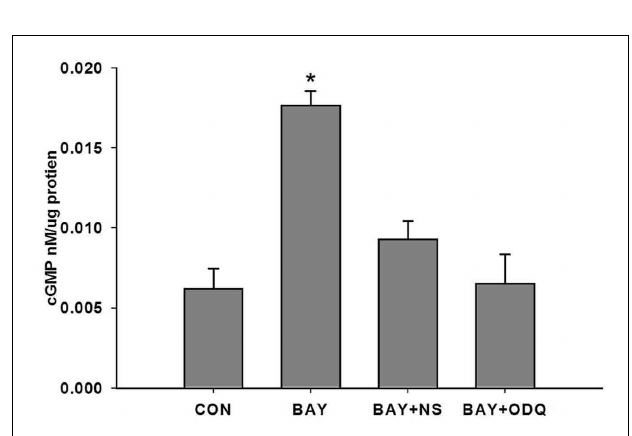
FIGURE 3 | (A) Effect of zaprinast (ZAP) on BAY 41-2272 (BAY)-induced increases in cGMP.VSMCs were pretreated with ZAP (ZAP, 10 μ M) or vehicle for 30min prior to stimulation with BAY (10 μ M) for 60min ( n = 11).Values are the means ± SE. *Different from control ( P < 0.05). (B) Effect of vardenafil (VAR) on BAY-induced increases in cGMP.VSMCs were pretreated withVAR (50nM) or vehicle for 30min prior to stimulation with BAY (10 μ M) for 60min